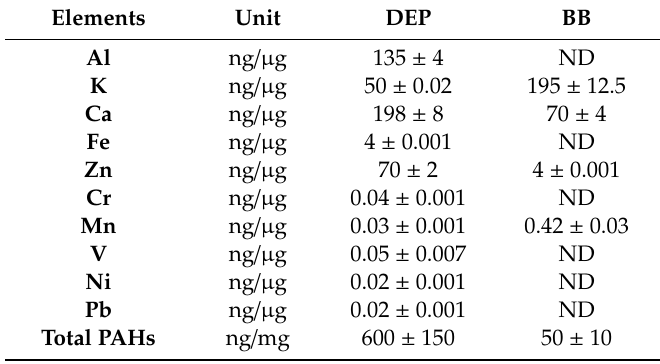
Table 2. Chemical compositions of UFPs from di ff erent anthropogenic sources, reported in Longhin et al., 2016. [56] Each value is expressed as mean concentrations ( ±